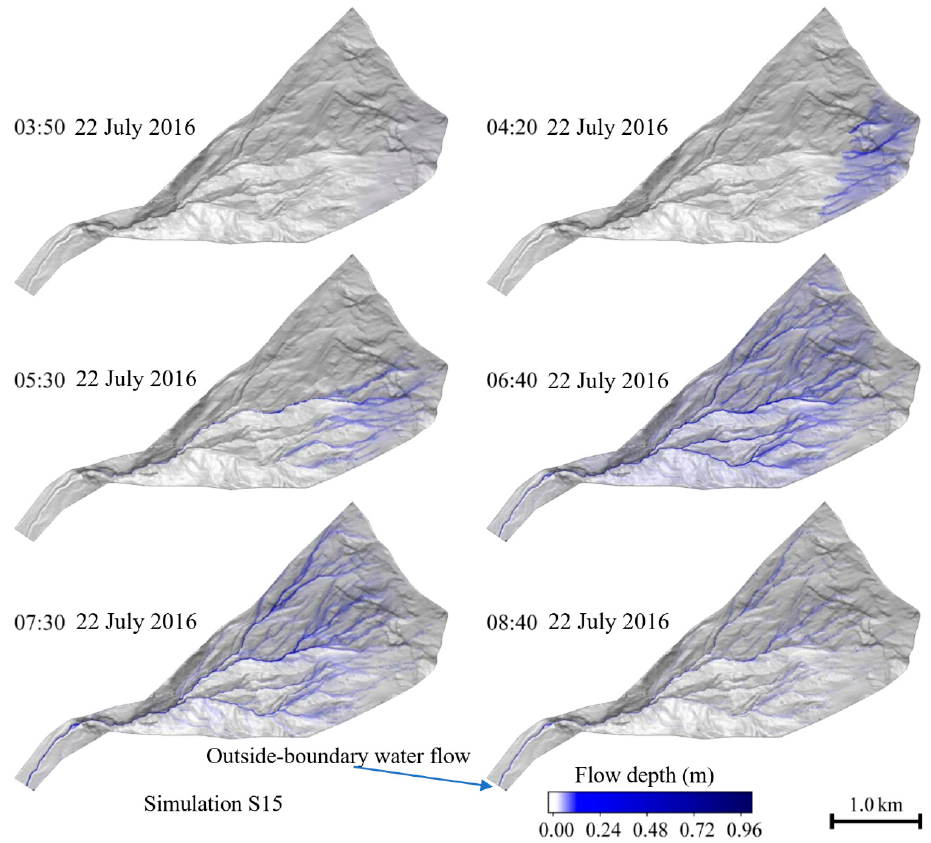
Figure 11. Simulation S15: visualization of the distribution of water within the basin during the debris flow occurrence transitory over time, including infiltration.